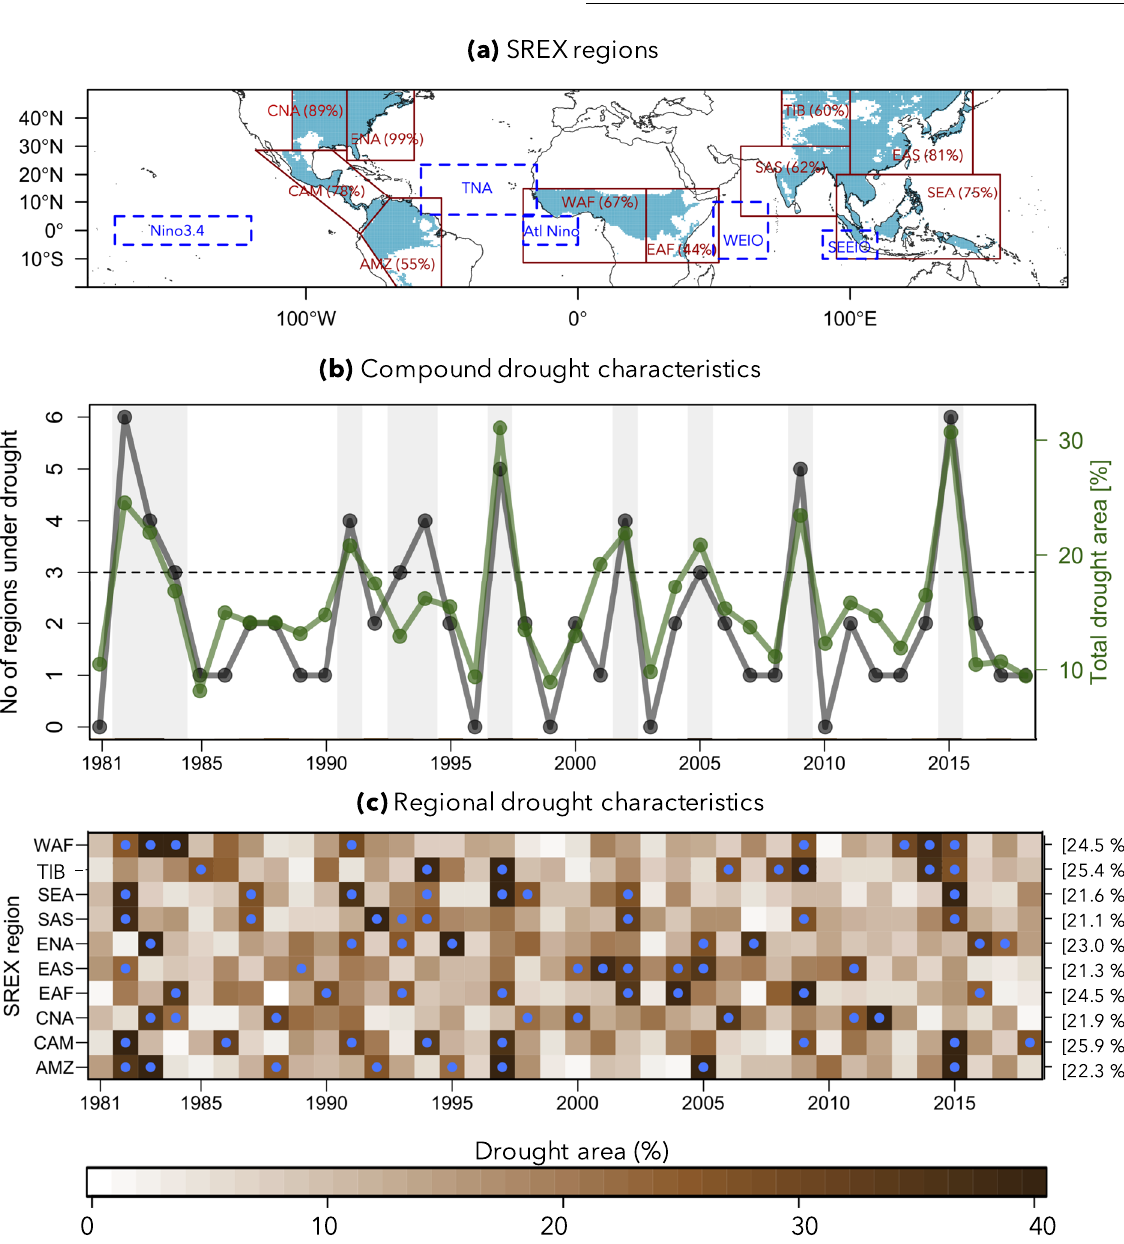
Fig. 1 Historical characteristics of compound drought events. a Map showing the ten SREX regions (red line) and the ocean regions (blue dashed lines) used to de fi ne various modes of variability considered in this study. Red text indicates the fraction of each SREX region with high entropy values [entropy > 4.86, which is the median entropy value across ten SREX regions] (teal color). b Historical timeseries of the number of regions experiencing summer season (June – September) drought (gray) and the total drought affected area (green) based on the Climate Hazards Group InfraRed Precipitation with Station (CHIRPS) precipitation data (1981 – 2018). The gray dashed line indicates the threshold of the number of regions used to de fi ne a compound drought event. Gray shading indicates the years with compound droughts. c Drought affected area in each season over each SREX region. Blue circles indicate seasons when the drought-affected area exceeds 80 th percentile of the long-term average drought area. The magnitude of the 80 th percentile thresholds for drought area are indicated on the right beside each